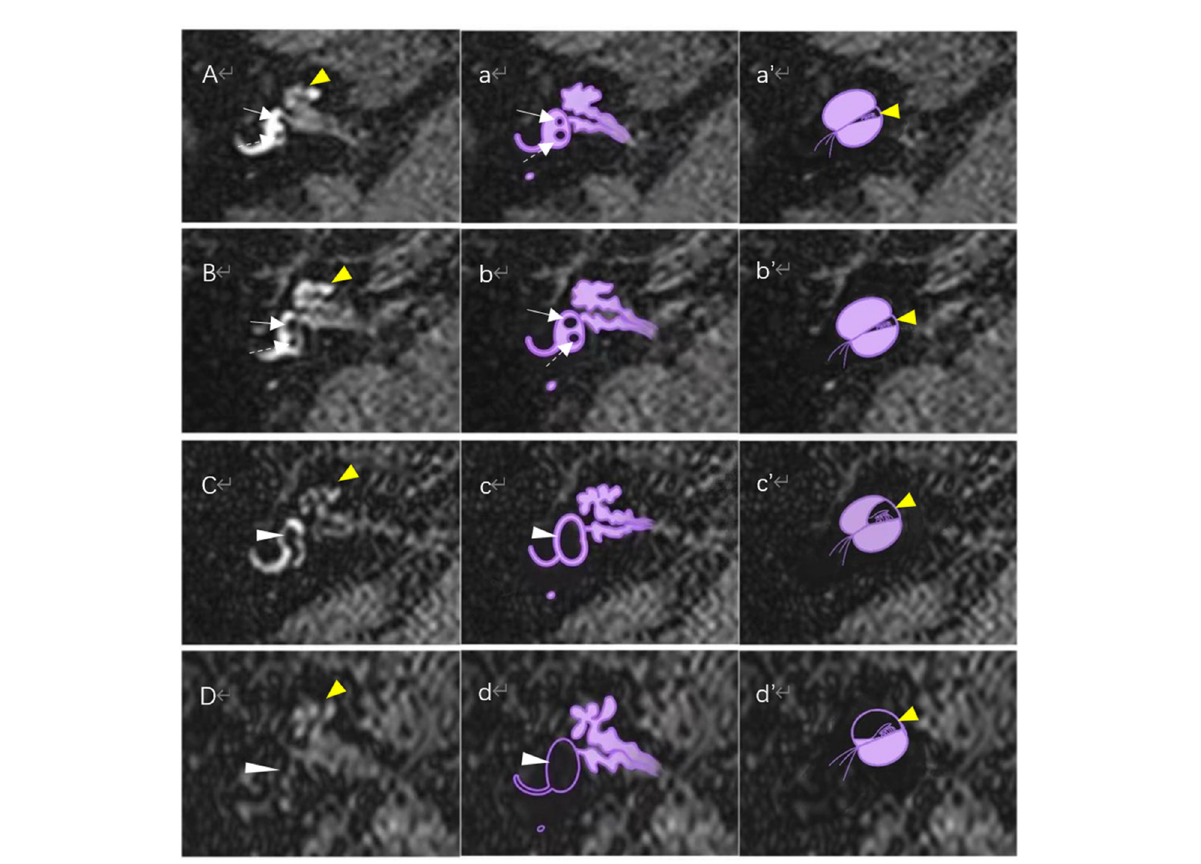
FIGURE1 Magnetic resonance imaging of different degrees of endolymphatic hydrops on the axial reference plane of the lower vestibular and schematic diagram of the corresponding vestibular and cochlear endolymphatic hydrops. (A) Normal vestibule and normal cochlea: Saccule (white solid-line arrow) and utricle (white dotted arrow) are distinctly separated, and the saccule area is smaller than the area of the utricle; no enlargement of the scala media (yellow arrowhead). (B) FSVH grade I (or SURI grade 1) and normal cochlea: saccule (white solid-line arrow) appeared equal or larger than the utricle (white dotted arrow), but is not yet confluent with the utricle; no enlargement of the sacala media (yellow arrowhead). (C) FSVH grade II (or SURI grade 2): There is a confluence of the saccule and utricle (white arrowhead) with still a peripheral rim enhancement of the perilymphatic space. The scala media expands toward the vestibular scala vestibuli, which is still visible. (D) FSVH grade III (or SURI grade 2): The saccule and utricle are fused (white arrowhead) and peripheral ectolymphatic enhancement is no longer visible; the scala media is enlarged toward the scala vestibuli,which is barely visible. (a–d) are schematic diagrams of vestibular hydrops corresponding to (A–D) , respectively. (a ′ -d ′ ) are schematic diagrams of cochlear hydrops corresponding to (A–D) ,